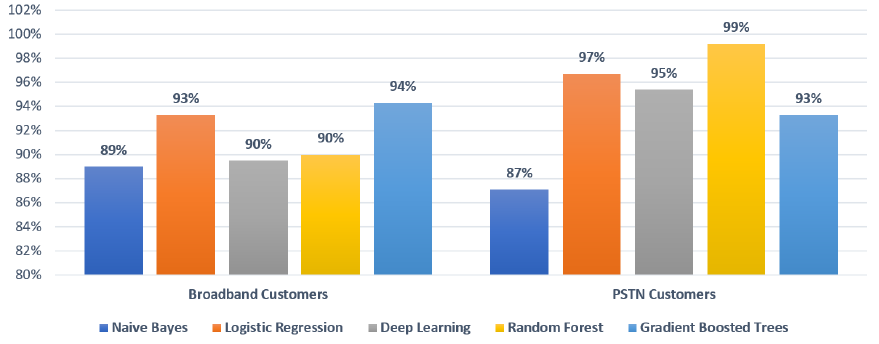
Figure 16. Prediction accuracy with five classification algorithms.